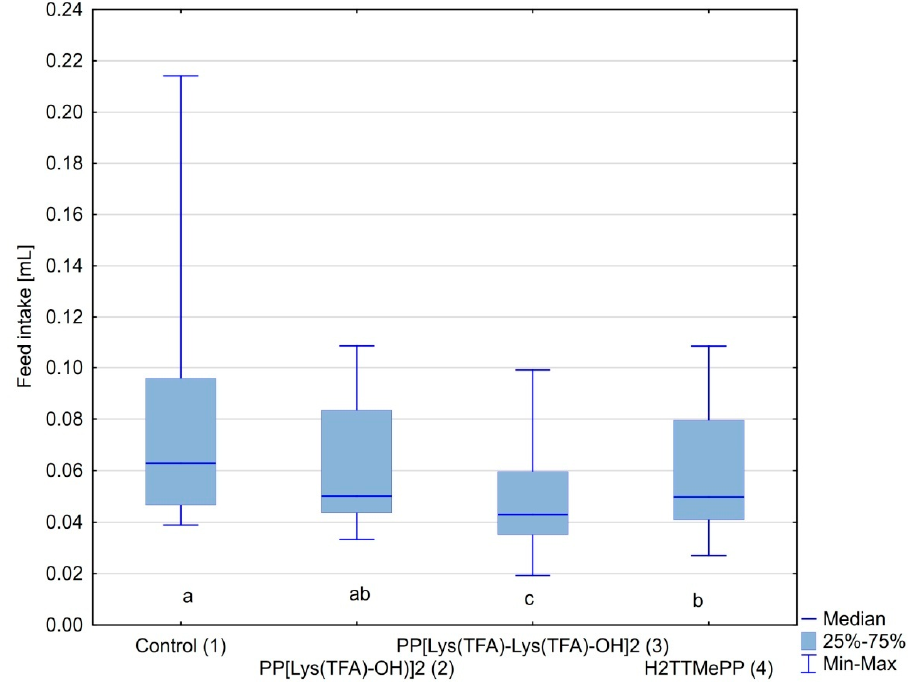
Figure 4. The amount of syrup consumed per bee per day. Lowercase letters ( a – c ) indicate the differences among the groups ( p < 0.05; Kruskal-Wallis test).